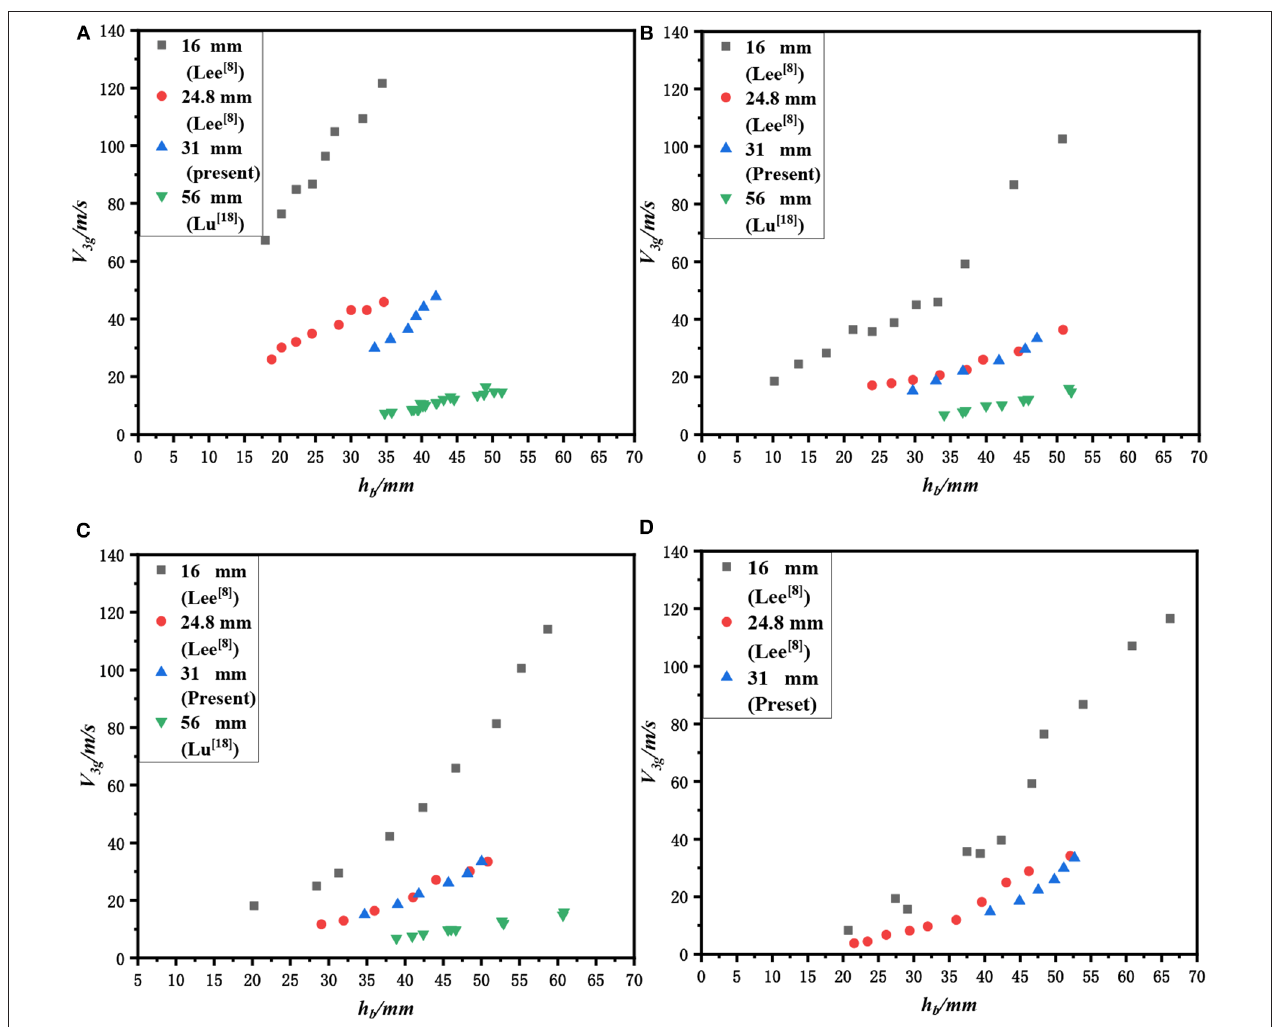
FIGURE 3 | Comparison of entrainment onset data at different branch sizes (Lee et al., 2007; Lu et al., 2018) (A) Branch angle: 30 ◦ , (B) Branch angle: 45 ◦ , (C) Branch angle: 60 ◦ , and (D) Branch angle: 90 ◦